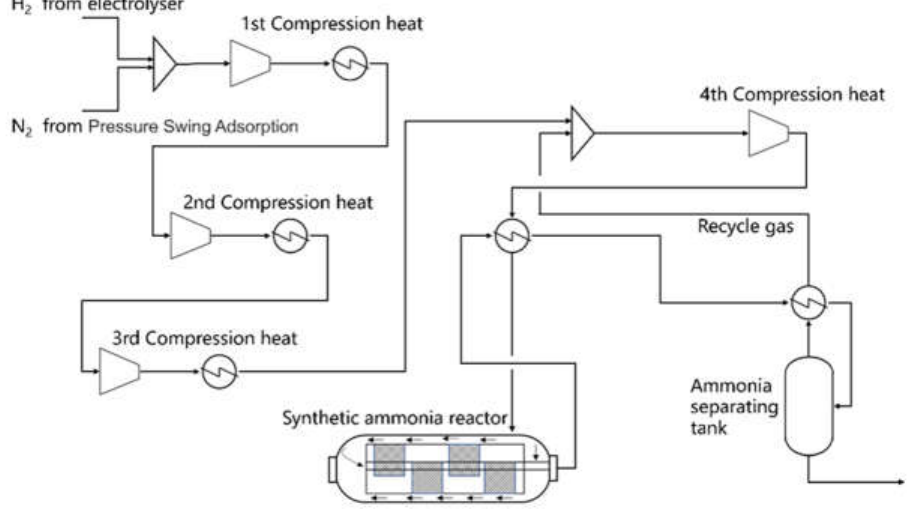
Figure 2. Green ammonia process flow chart.